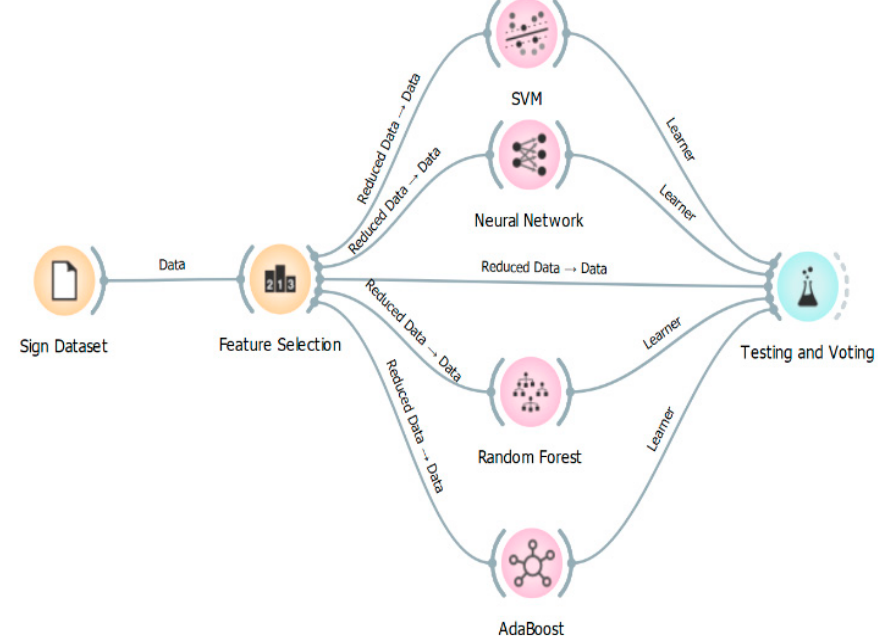
Figure 4. The architecture of hand gestures classification using ensemble learning.